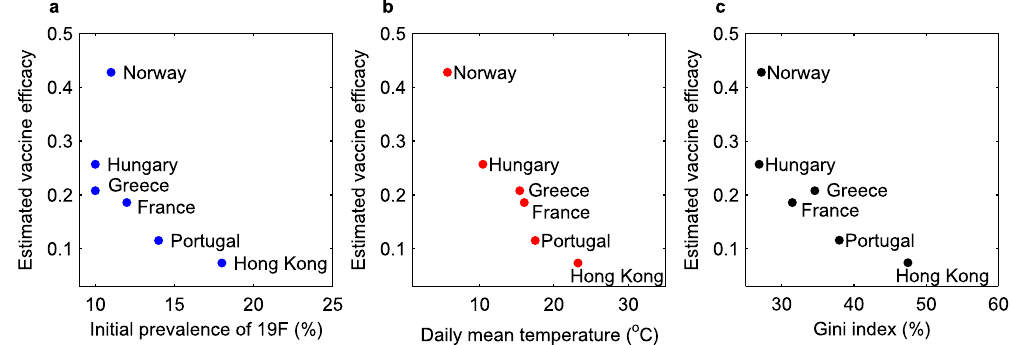
Figure 5. Possible factors for variation in vaccine efficacy against acquisition. ( a ) Prevalence of serotype 19F pre-PCV7 and model-based vaccine efficacy estimates. The decreasing trend suggests that high initial frequency of a serotype for which vaccine protection may be inferior (e.g. 19F) could influence model estimates of the net realized vaccine efficacy against PCV7 serotypes when aggregated together, ( R 2 = 47%, ( R 2 -adj = 11%, GLM fit: ρ = − 0.0003, p = 0.10 n.s.). ( b ) Temperature across countries correlates with vaccine efficacy